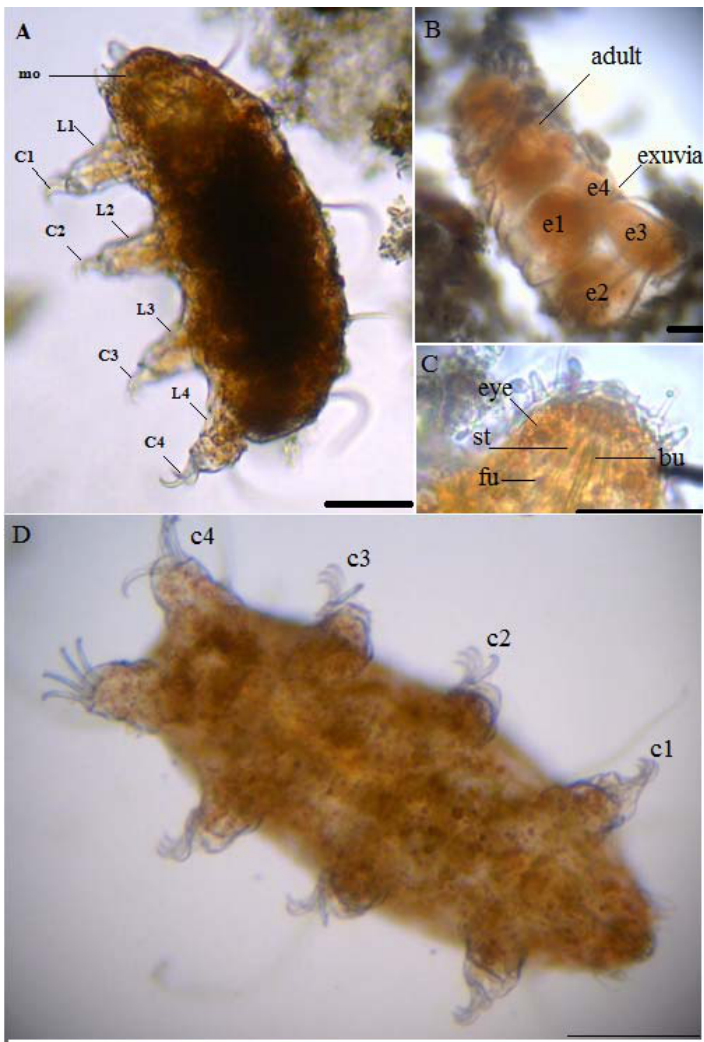
F IGURE 2. General anatomy of E. testudo . Scale bars equal 25 μ m (A) Differential interference micrograph showing ventrolateral view of the left side of an adult E. testudo specimen. The anteroposterior axis includes a head and four trunk segments, each with a pair of legs (left legs are